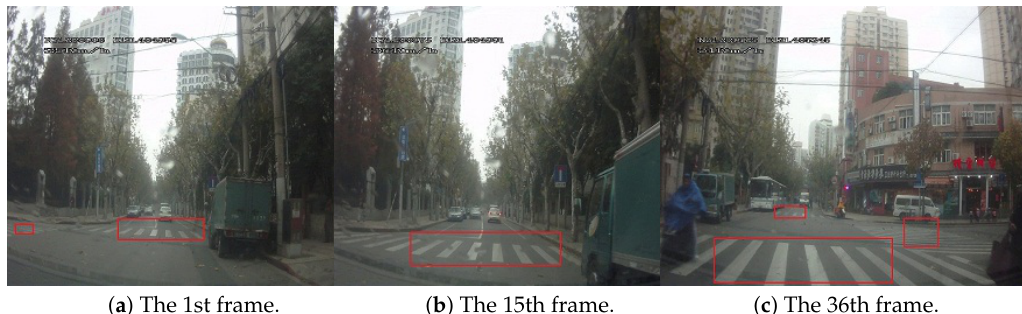
Figure 11. Frames from video showing detection of multiple pedestrian crossings in real traffic